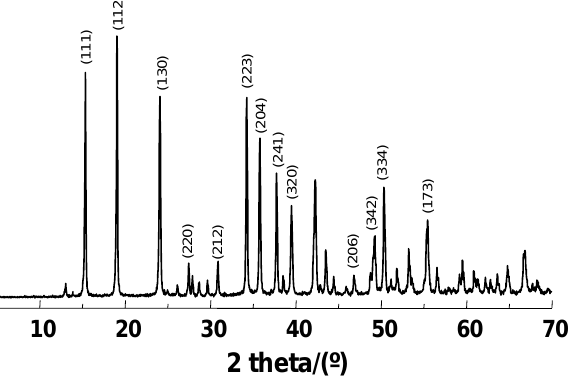
Figure 1. Powder X-ray diffraction (XRD) pattern of as-made GdFe nanorods